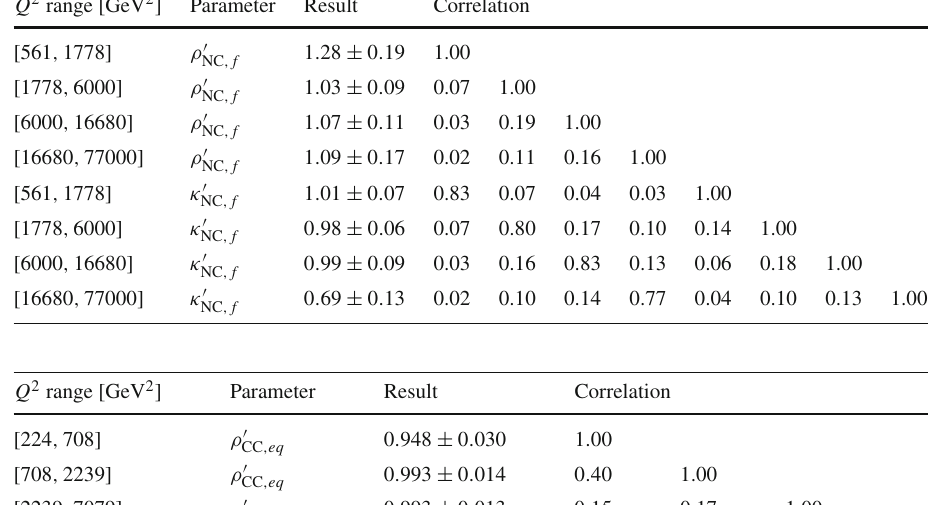
Table 17 Results for the ρ (cid:6) parameters determined at different values of Q 2 . The Q 2 range of the data selection, and the correlation coefficients of the fit parameters are indicated